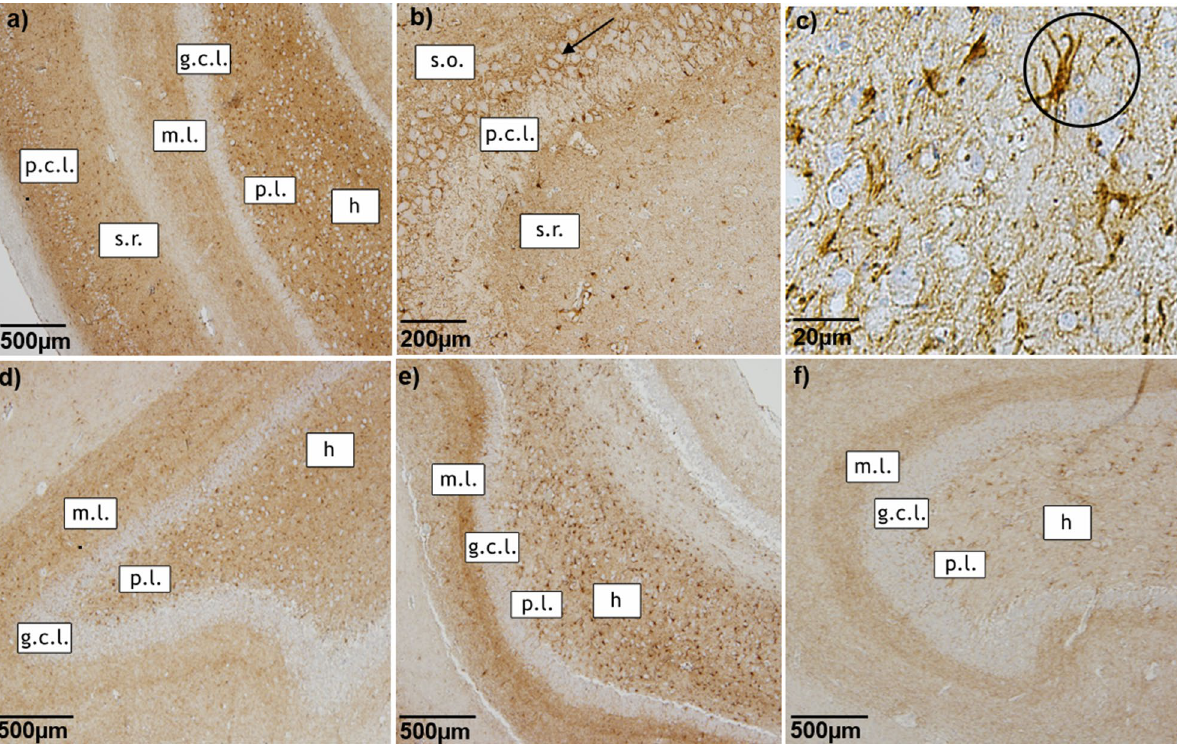
Figure 1. CB1R immunostaining of hippocampus. Representative microphotographs of CB1R immunoreactivity in the hippocampus of a control dog ( a – d ), a dog with structural epilepsy ( e ) and a dog with idiopathic epilepsy ( f ). Pyramidal cell layer (p.c.l.) exhibits strong CB1R signal surrounding the unstained soma ( a , b ) with intense dot-like CB1R immunoreactivity (arrow in b ). The dentate gyrus of the hippocampus demonstrates distinct dot-like CB1R immunoreactivity in the molecular layer (m.l.) and hilus (h), whereas granule cell layer (g.c.l.) appears to be devoid of CB1R immunoreactivity ( a , d , e , f ). The circle shows strong CB1R labeling of cells with astrocytic morphology ( c ): p.l.- polymorphic layer; s.o.—stratum oriens, s.r.— stratum